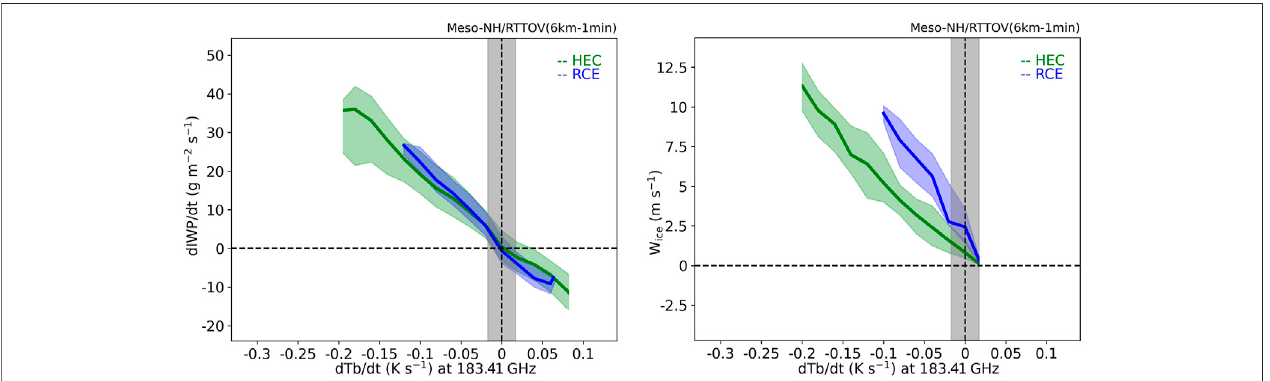
FIGURE6| HistogramofdIWP/dt(left,ing/m 2 /s)andw ice (right,inm/s)asafunctionofdTb/dtforthe183.41 GHzchannel,at6 kmresolutionandwithatimedelay ofthesatellitetandemof1 min. Thebinintervalis0.02 K/s.Themedian(boldlines)andtheinterquartileranges(shadings)areshownforHECTOR (HEC/green)andRCE (blue).ThegreybanddelimitsadTb/dtuncertainty of0.017 K/s,correspondingtoa1 Kuncertainty intheTbmeasurementfora1 mintime-delaybetweenthesatellites. Results are shown for gridpoints verifying the deep convection criterion at 183 GHz (see text), restricted to growing cores for w ice (right).